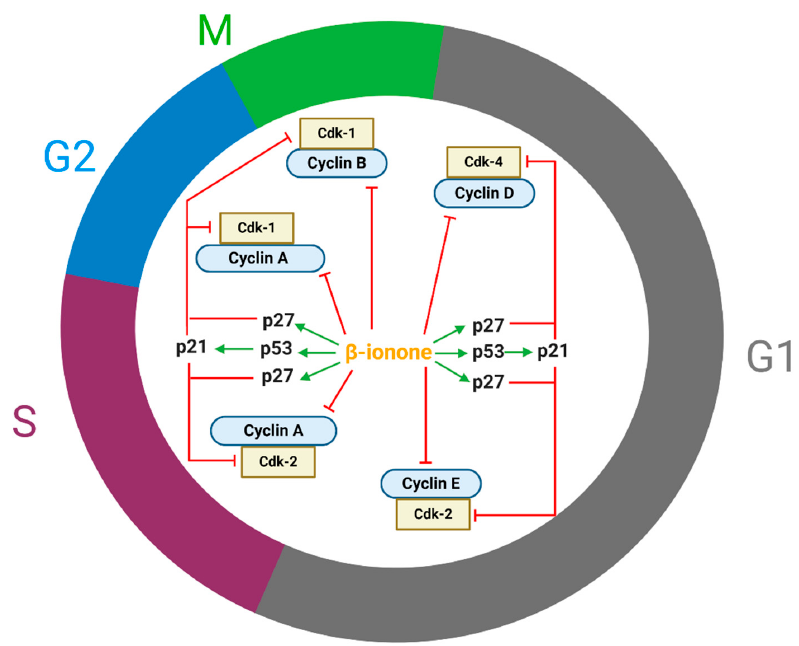
Figure 2. β -Ionone modulates several cell cycle regulatory proteins causing cell cycle arrest in various cancer cells (Cdk-1, cyclin-dependent kinase-1; Cdk-2, cyclin-dependent kinase-2; Cdk-4, cyclin- cancercells(Cdk-1, cyclin-dependentkinase-1; Cdk-2, cyclin-dependentkinase-2; Cdk-4, cyclin-dependent dependent kinase-4; p27, cyclin-dependent kinase inhibitor; p21, cyclin-dependent kinase inhibitor). kinase-4; p27, cyclin-dependent kinase inhibitor; p21, cyclin-dependent kinase